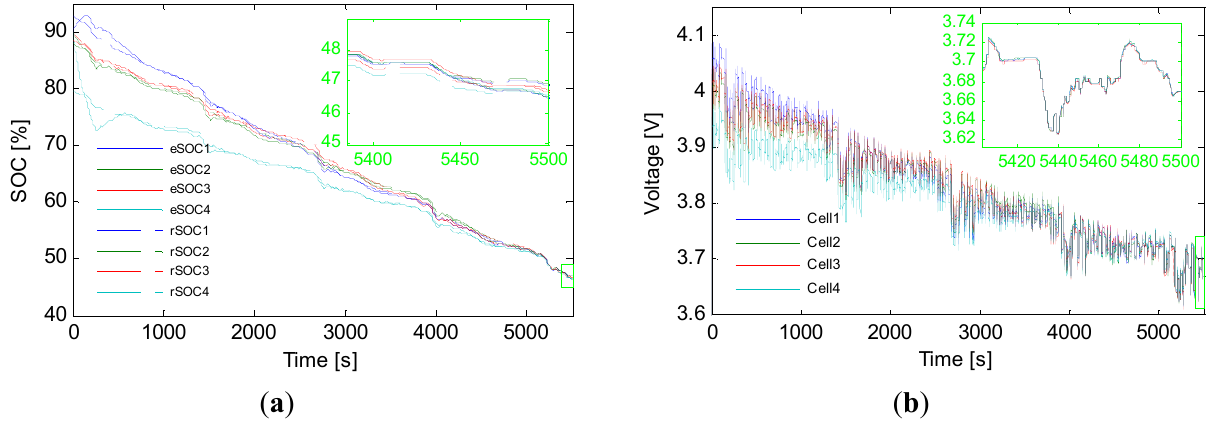
Figure 11. The Results of the experiment in situation 1: ( a ) SOC balancing results; ( b ) Voltage results.